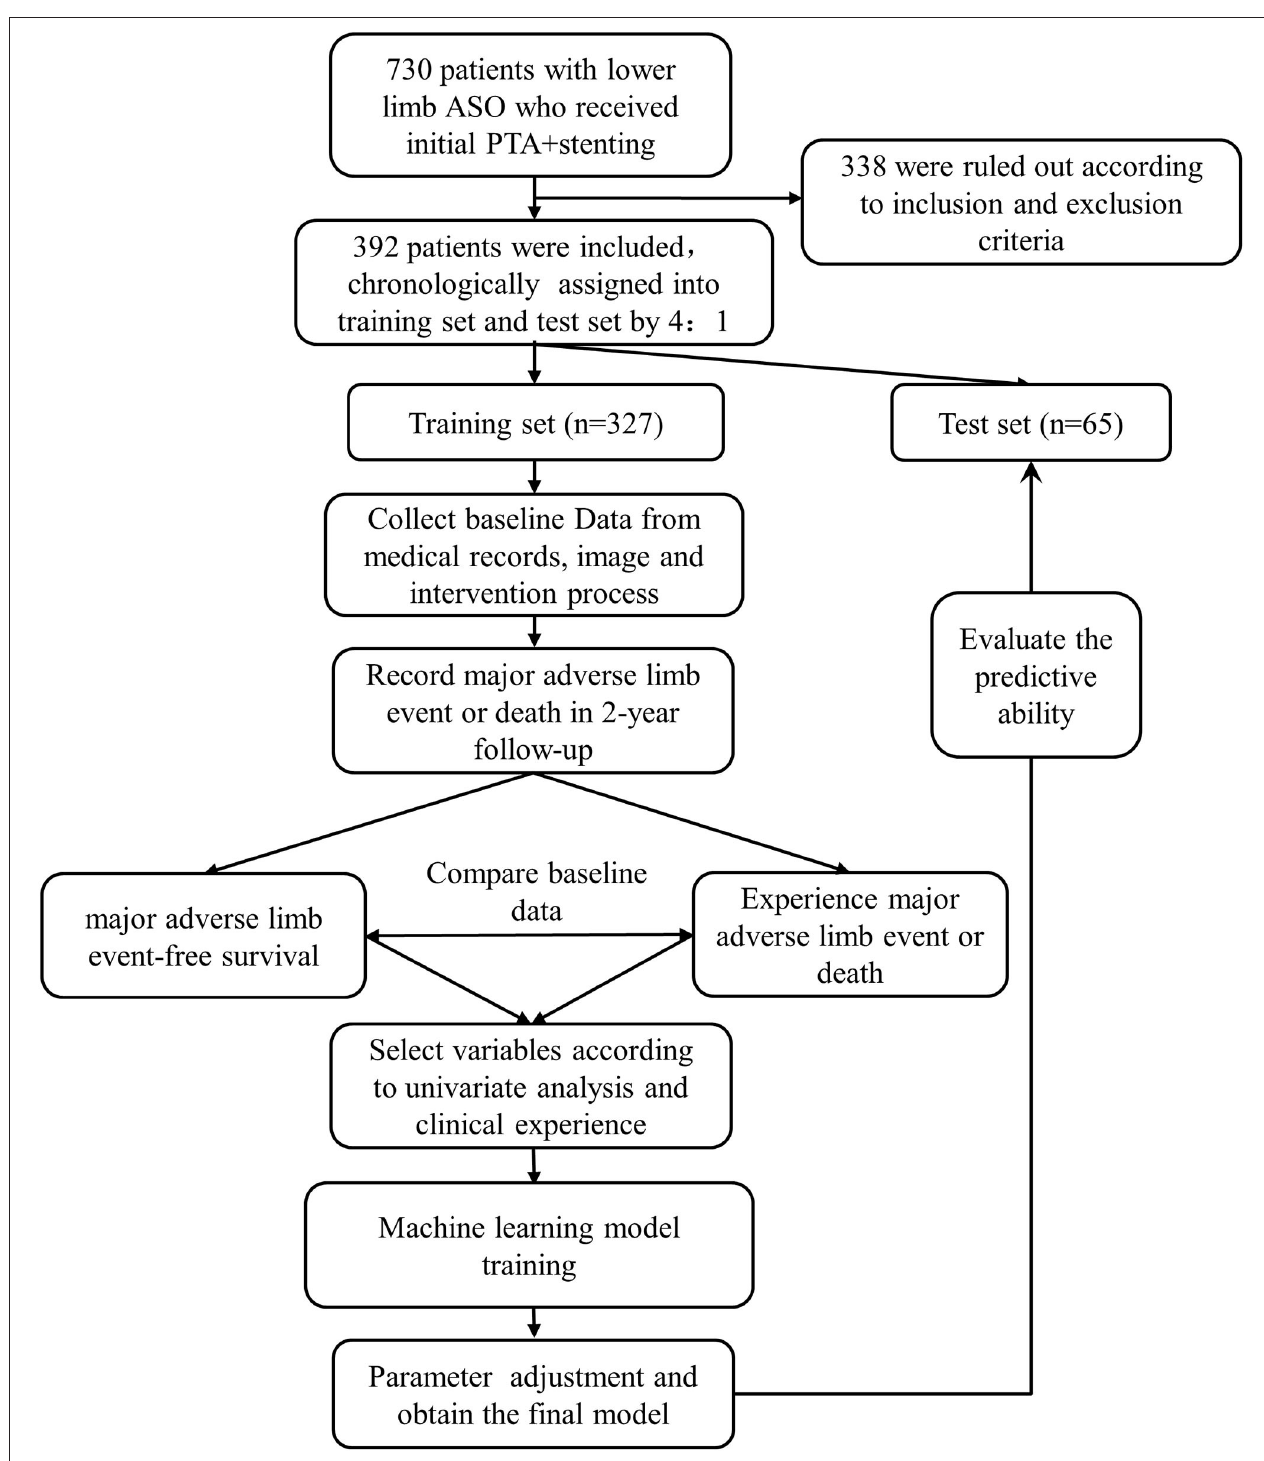
FIGURE 2 | Study flow diagram. PTA, percutaneous transluminal angioplasty.